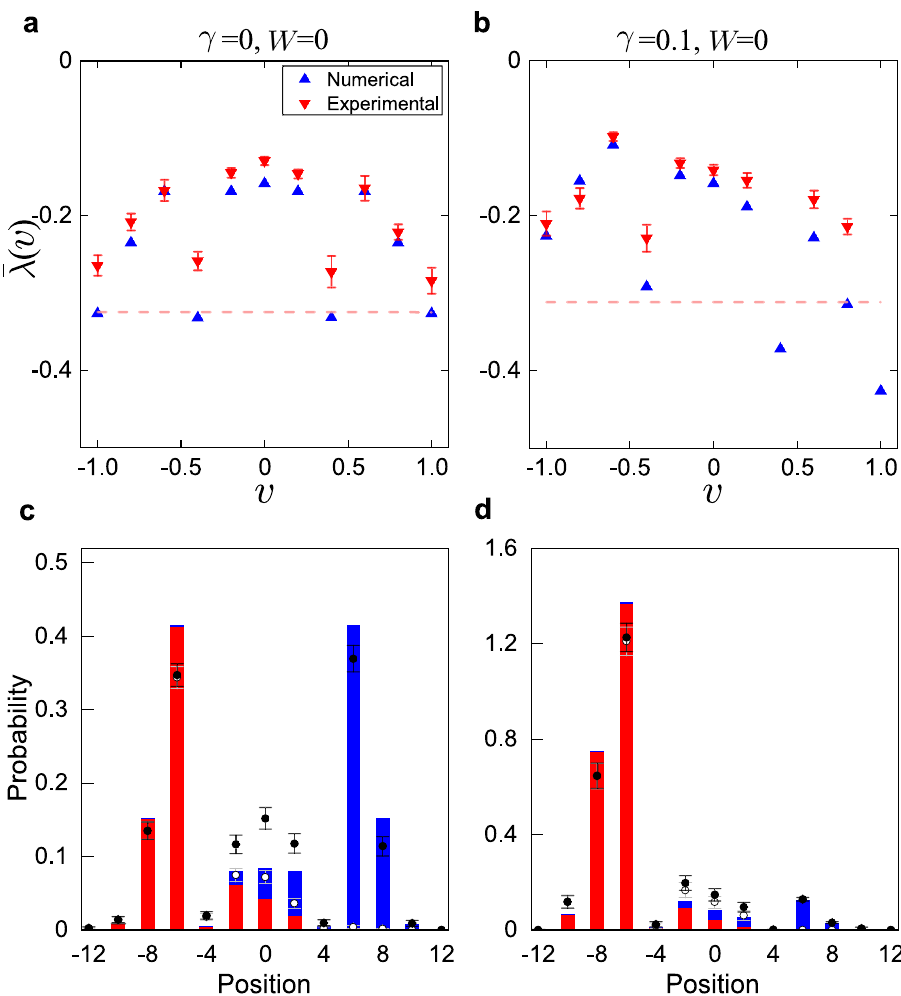
Fig. 2 Lyapunov exponent from bulk dynamics. Measured polarization-averaged growth rates (cid:1) λ ð v Þ for a unitary quantum walk with γ = 0 in ( a ) and a non- unitary quantum walk with γ = 0.1 in ( b ). Red triangles with error bars are the experimental data and blue triangles are from numerical simulations. The horizontal dashed line indicates the threshold values below which experimental data were no longer reliable due to photon loss. To construct (cid:1) λ , we initialize the walker in the state 0 j i (cid:3) H j i ( 0 j i (cid:3) V j i ), evolve it up to ten steps under the parameters ( θ 1 = 4.3, θ 2 = 2.175, W = 0), and projectively measure the horizontally (vertically) polarized photon distribution following the last time step. Note that the system is in a topologically non-trivial phase under the chosen parameters. We construct λ H and λ V from these polarization-resolved distributions, from which (cid:1) λ is calculated. c , d The polarization-resolved photon distribution after the last time step t = 10, for the dynamics in a and b , respectively. For each bar, the blue (top) and red (bottom) portions are respectively the numerical results for the horizontal-polarization-resolved and vertical-polarization-resolved photon distributions, initialized in 0 j i (cid:3) H j i and 0 j i (cid:3) V j i , respectively. The white dots are the experimental measurements for the vertical-polarization-resolved photon distribution, and black dots are the experimental results for the sum of the polarization-resolved distributions. Error bars are due to the statistical uncertainty in photon-number-